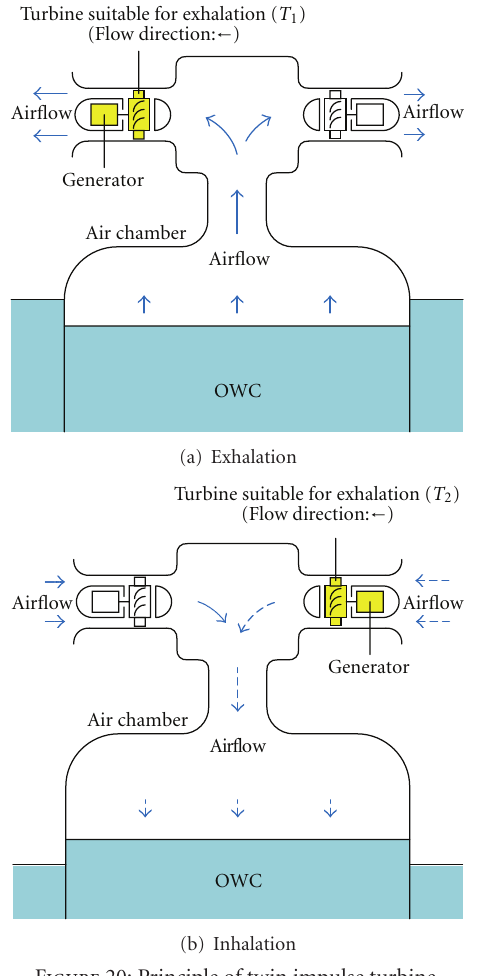
Figure 20: Principle of twin impulse turbine.